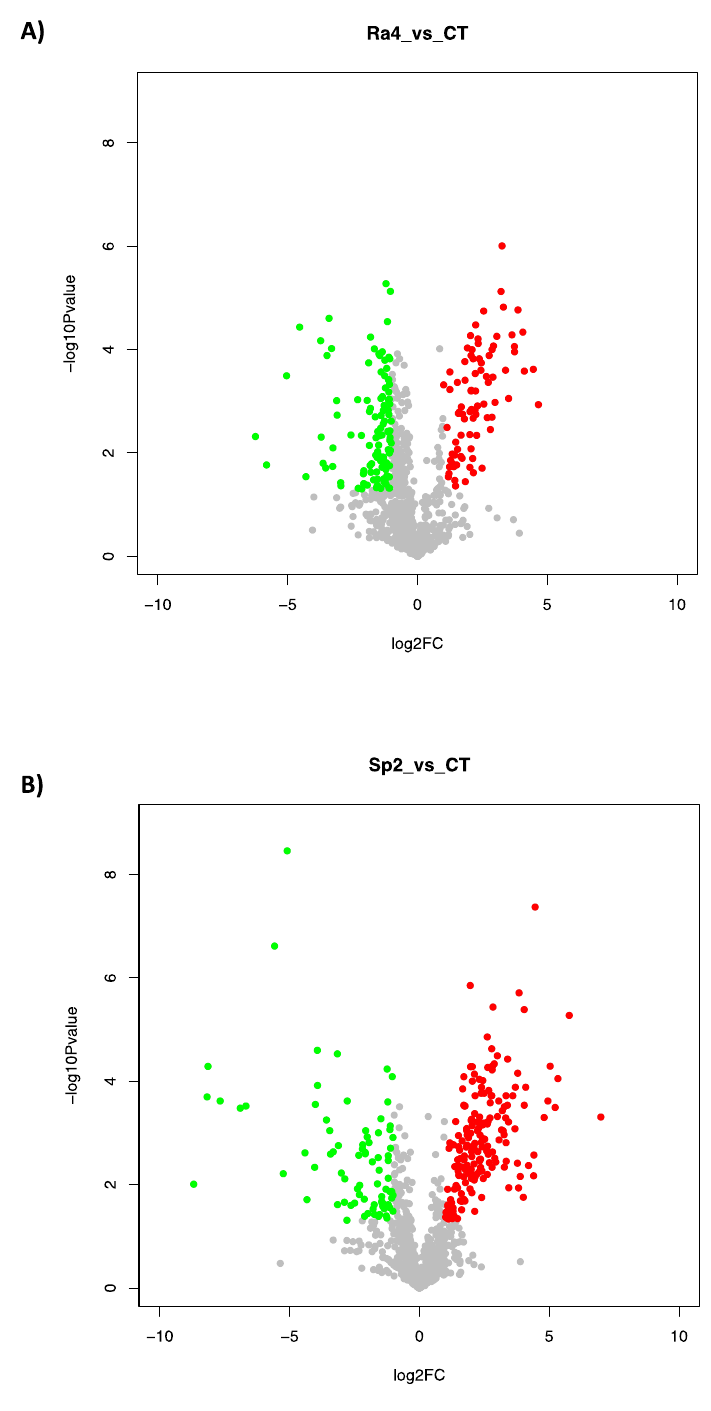
Figure 6. Analysis of differential proteins (DPs) in ( A ) Rahnella aquatilis and ( B ) Serratia plymuthica, 4.4% NaCl vs. Control (untreated cells). The X -axis represents the protein Log2fold change between the 2 groups; the Y -axis represents − 1xlog10 p -value ( p -value from t -test). The scattered points stand for each protein. No significant difference is indicated by grey color, significantly up-regulated and down-regulated proteins are indicated by red and green colors, respectively.